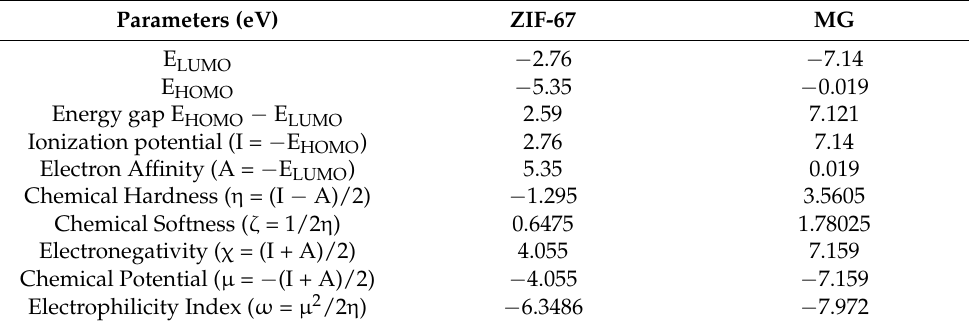
Table 1. HOMO and LUMO Energy Values and other related